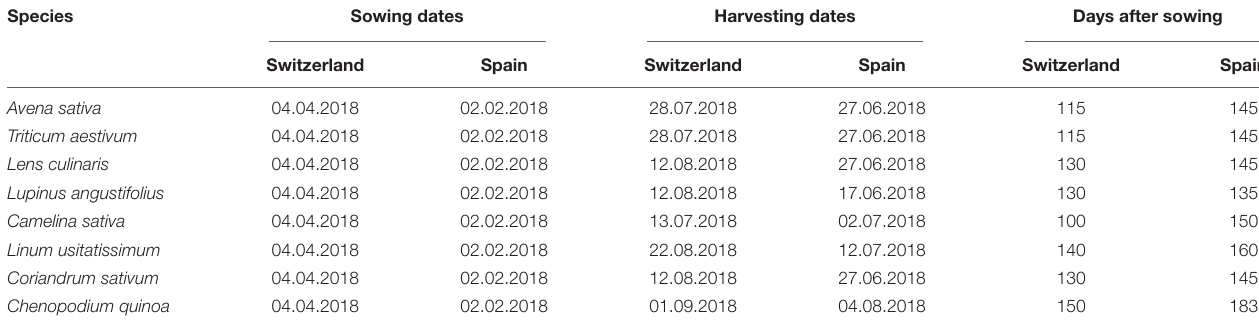
TABLE 1 | Sowing and harvesting dates, and crop growth duration in mean days after sowing from sowing until harvest for both countries and all eight